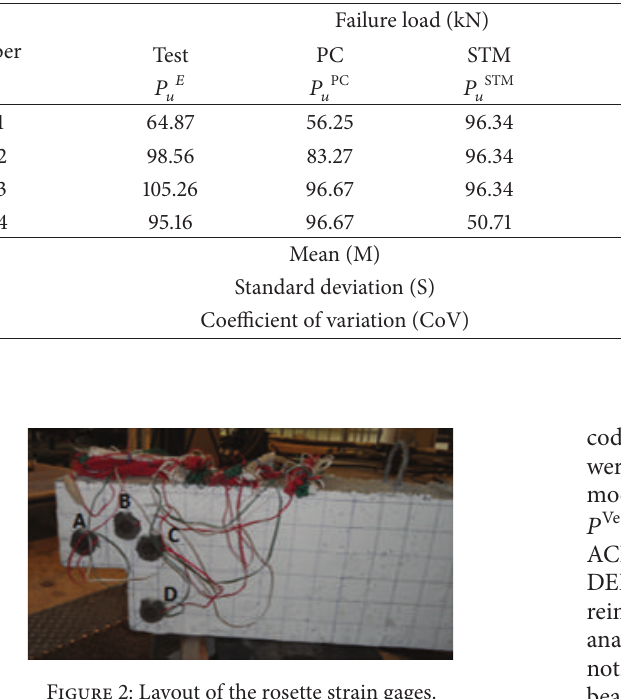
Table 3: Experimental and analysis results.